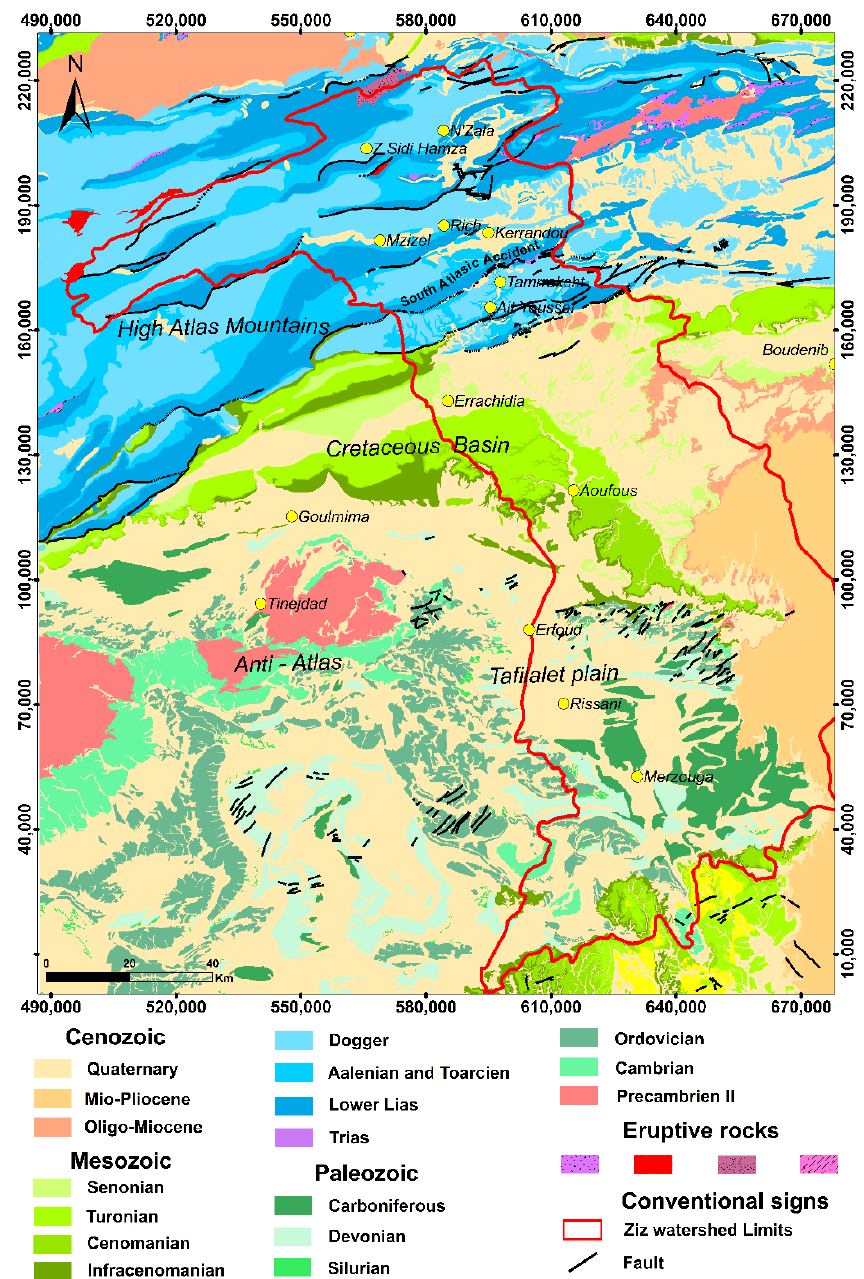
Figure 2. Geology of the study area.